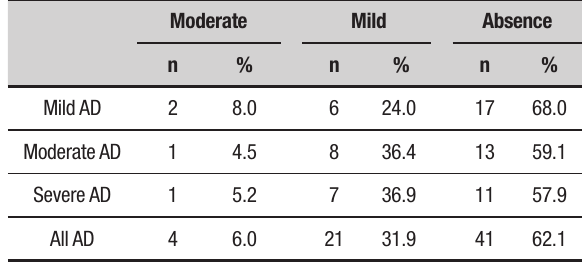
Table 5. Distribution of depression levels of family caregivers according to BDI. 9 São Carlos-SP, Brazil.